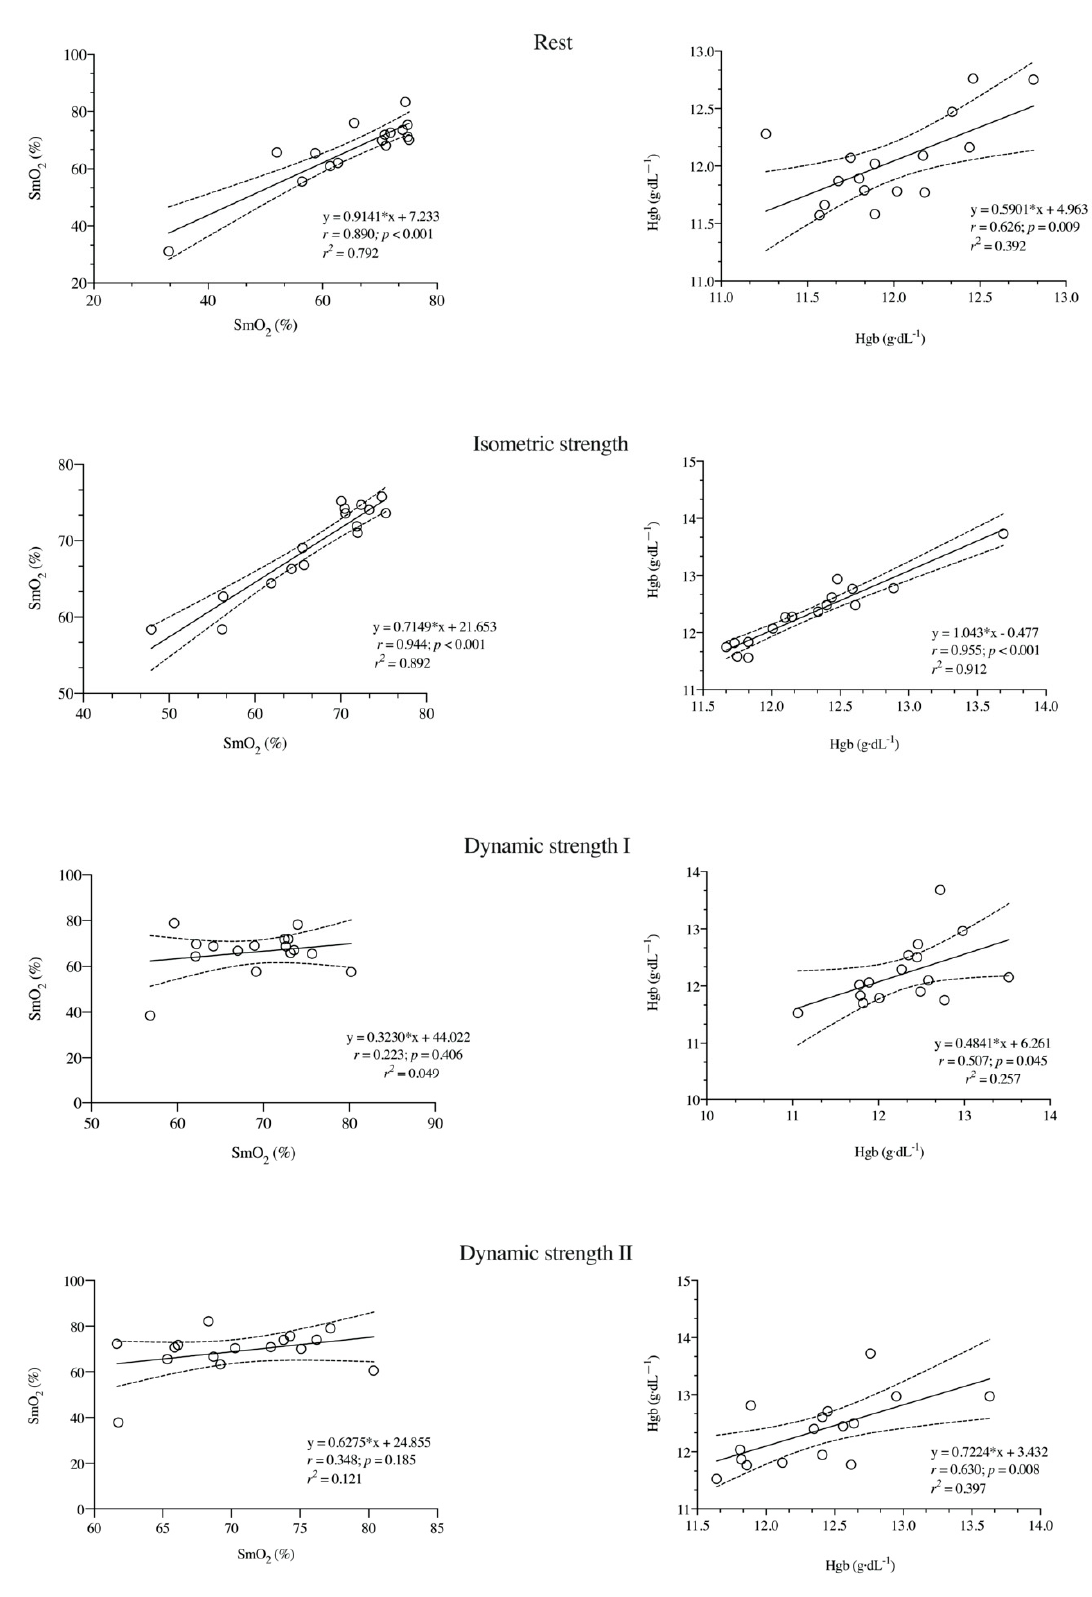
Figure 5. Relationship between SmO 2 and Hgb at rest and during isometric strength and dynamic strength (protocols I and II) conditions between both testing